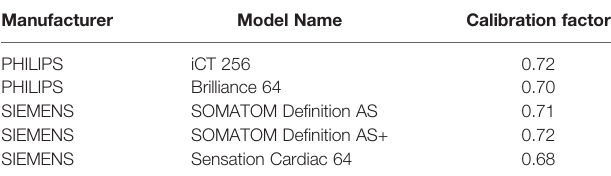
TABLE 1 | Scanner-speci fi c HU-to-vBMD calibration factors for tube load of 120 kVp.